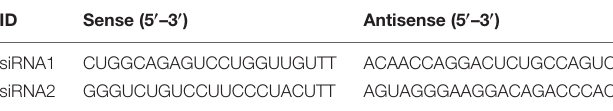
TABLE 2 | List of the KCNMA1 siRNA sequences. ID Sense (5 (cid:48) –3 (cid:48) )